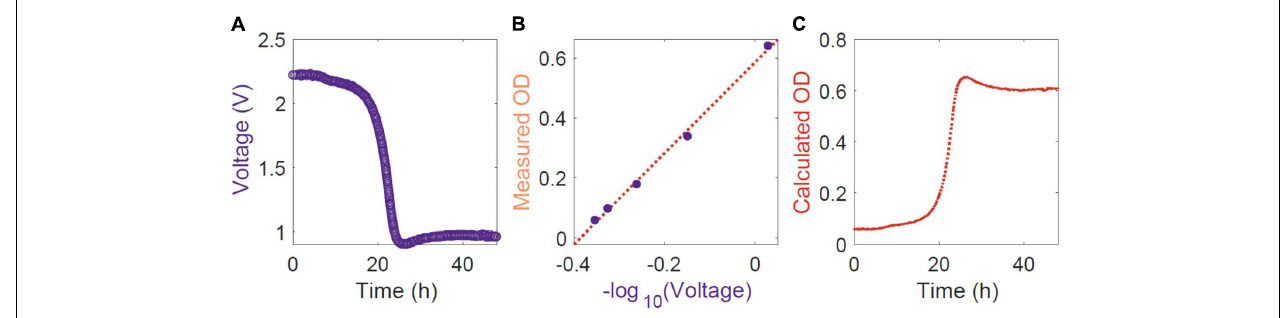
FIGURE 2 | Work flow of data analysis. (A) The raw voltage output of the self-fabricated OD-meters TubeOD or ClampOD was logged over time. (B) A calibration curve of log 10 transformed OD-meter voltage output to OD measurements in the commercial spectrophotometer at a wavelength of 600 nm was constructed (filled circles) and a linear (dotted line) or 2nd order polynomial regression function (not applicable here) was determined. (C) The corresponding calculated cuvette photometer OD was determined from the OD-meter output voltage and plotted as classical growth